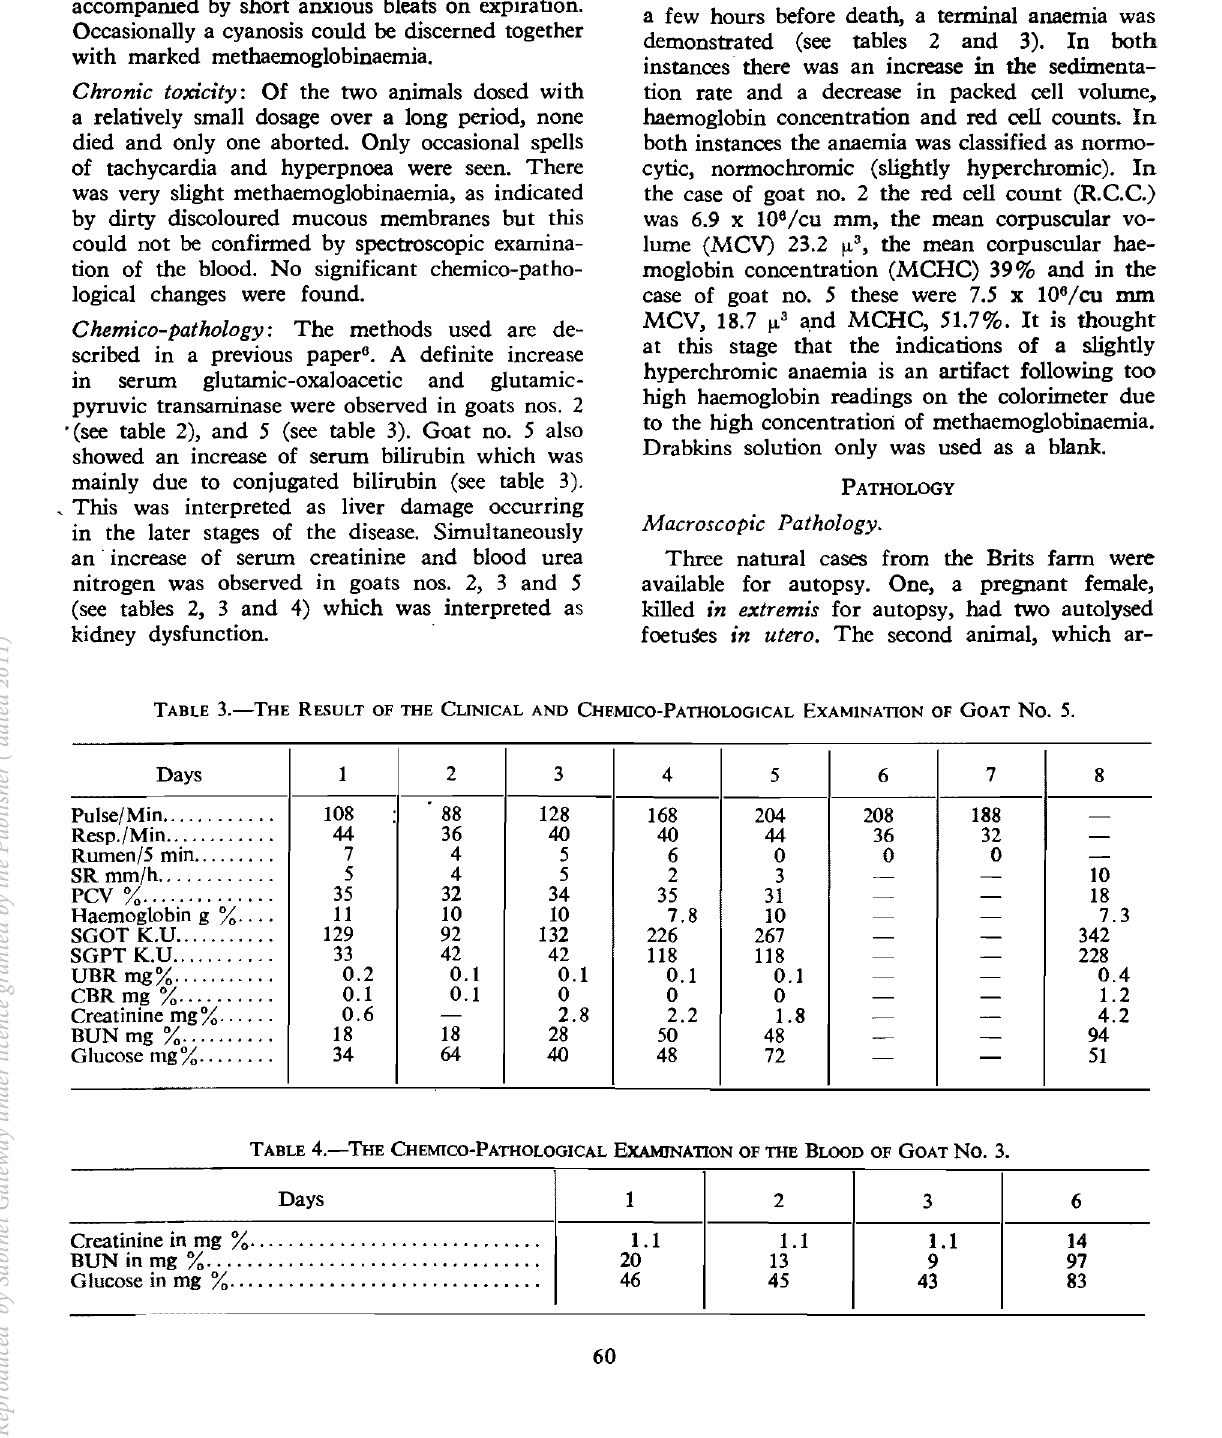
TABLE 3.-THE RESULT OF THE CUNICAL AND CHFMICO-PATHOWGICAL EXAMINATION OF GOAT No.5. Days